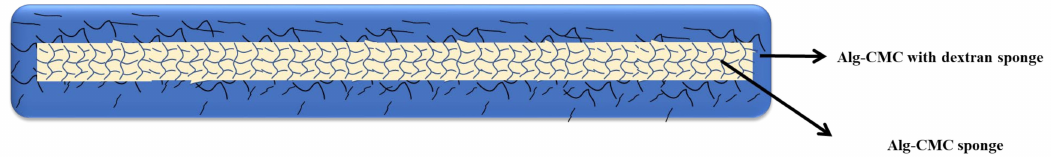
Figure 1. Concept of Alg-CMC hybrid dextran double-layer superabsorbent sponges